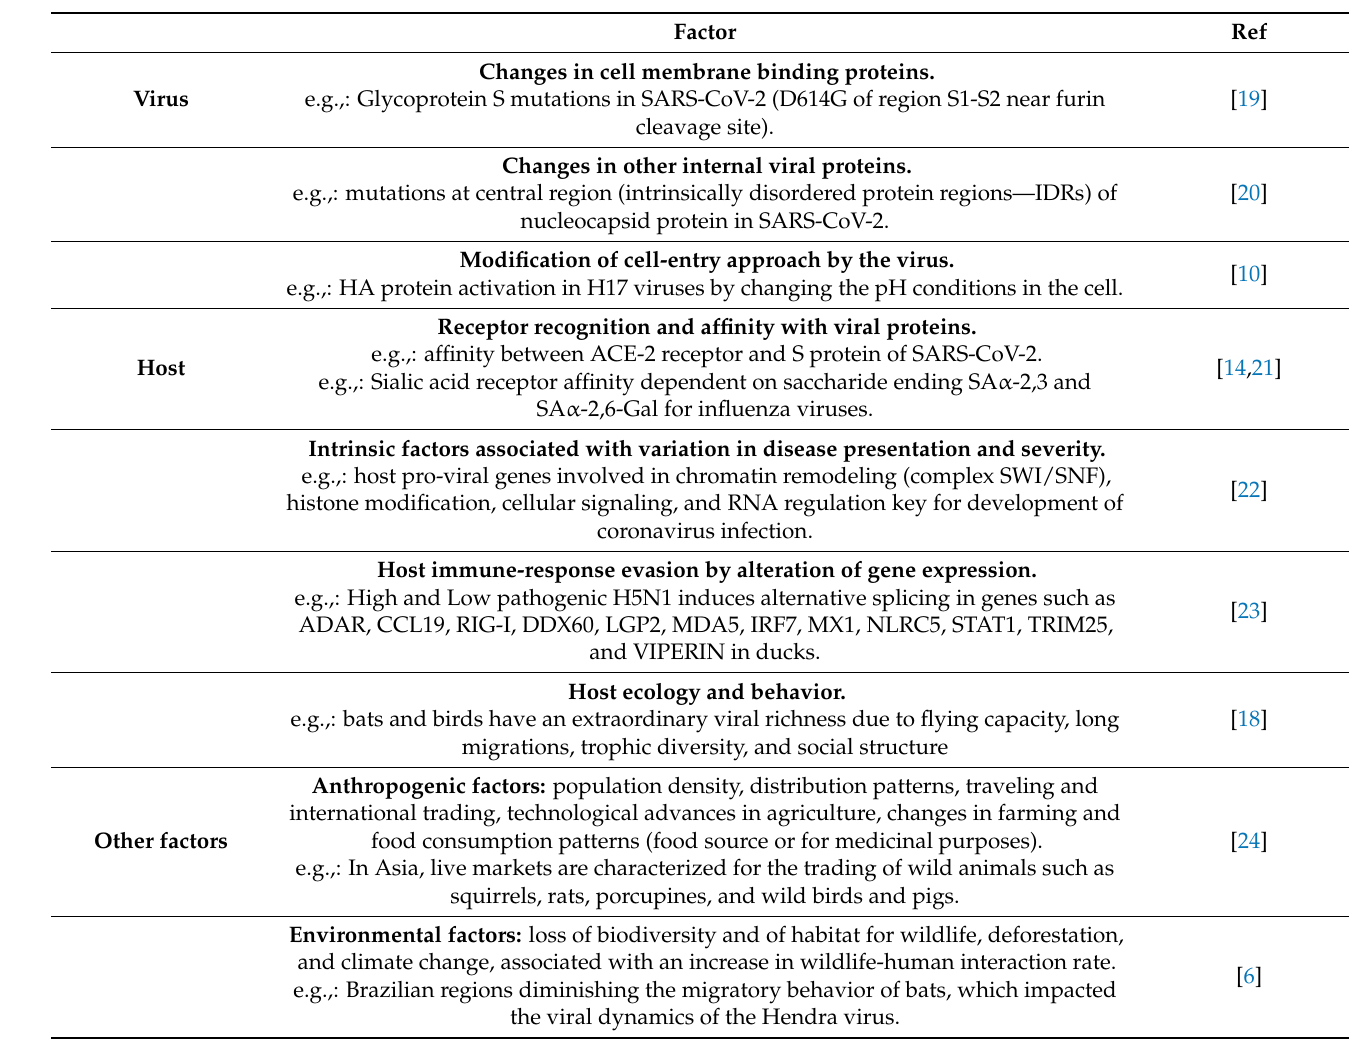
Table 1. Factors that enable pandemic potential of RNA viruses and interspecies